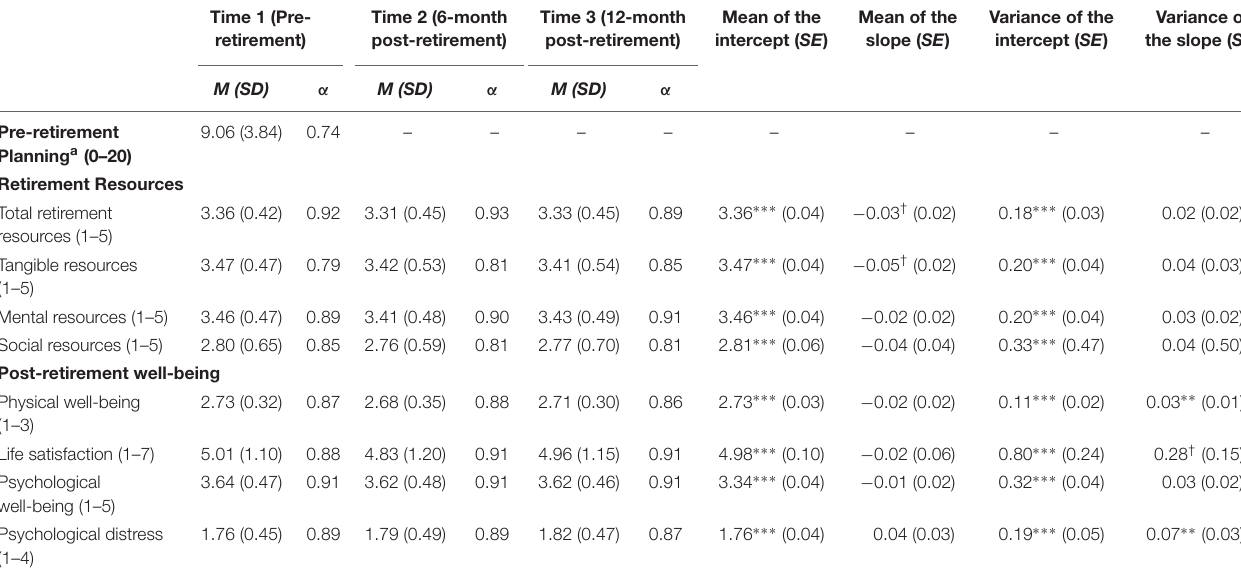
TABLE 1 | Descriptive statistics of Pre-retirement planning, retirement resources and Post-retirement well-being in Times